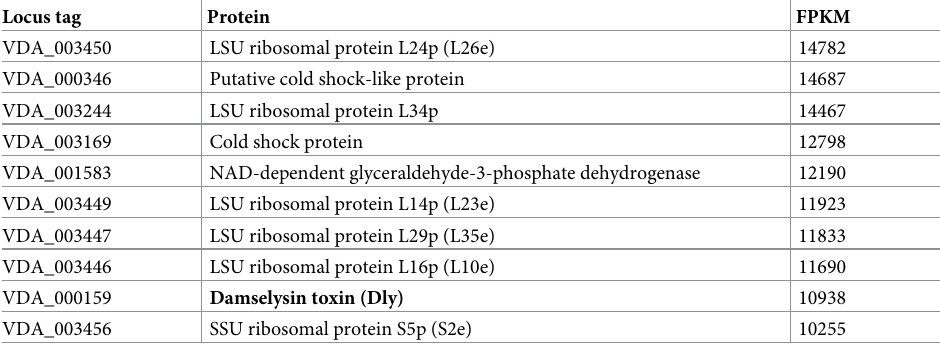
Table 3. List of most expressed genes at 15˚C and their corresponding FPKM values. Damselysin (Dly) toxin is highlighted in bold. FPKM values shown correspond to mean values of the three biological replicates. Locus